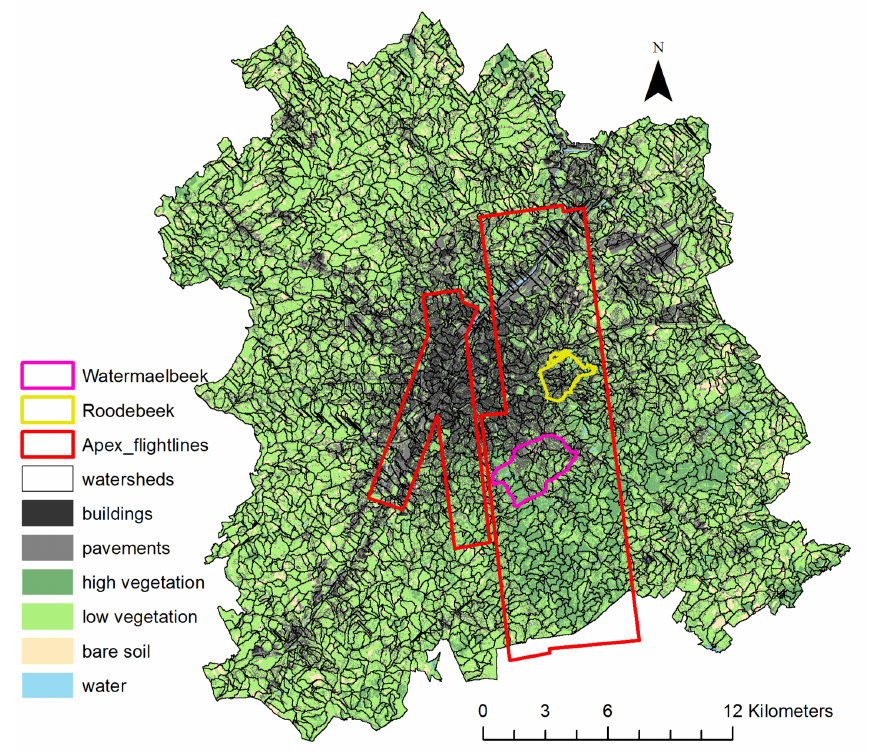
Figure 1. The Brussels capital region with the Watermaelbeek study site (pink), the Roodebeek validation site (yellow) and the APEX (Airborne Prism Experiment)flightlines